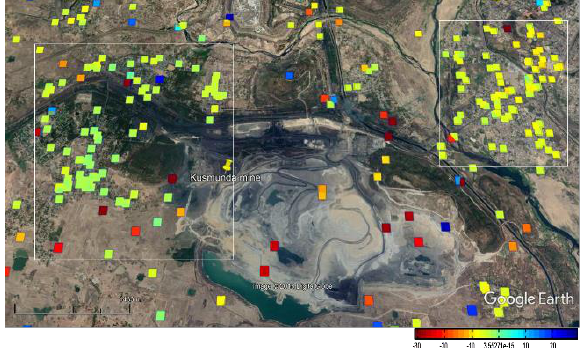
Figure 7 Zoomed view of Kusmunda opencast mine